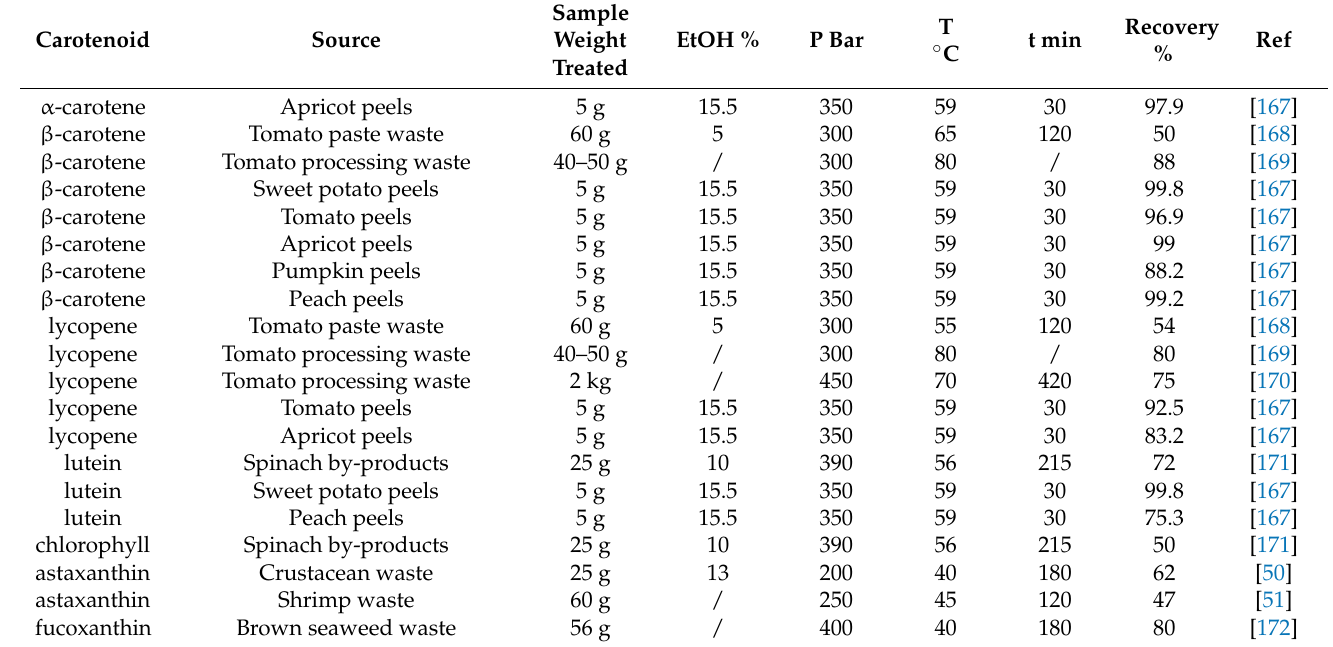
Table 2. Extraction of carotenoids by supercritical carbon dioxide. EtOH = ethanol; P = operating pressure; T = operating temperature; t = extraction